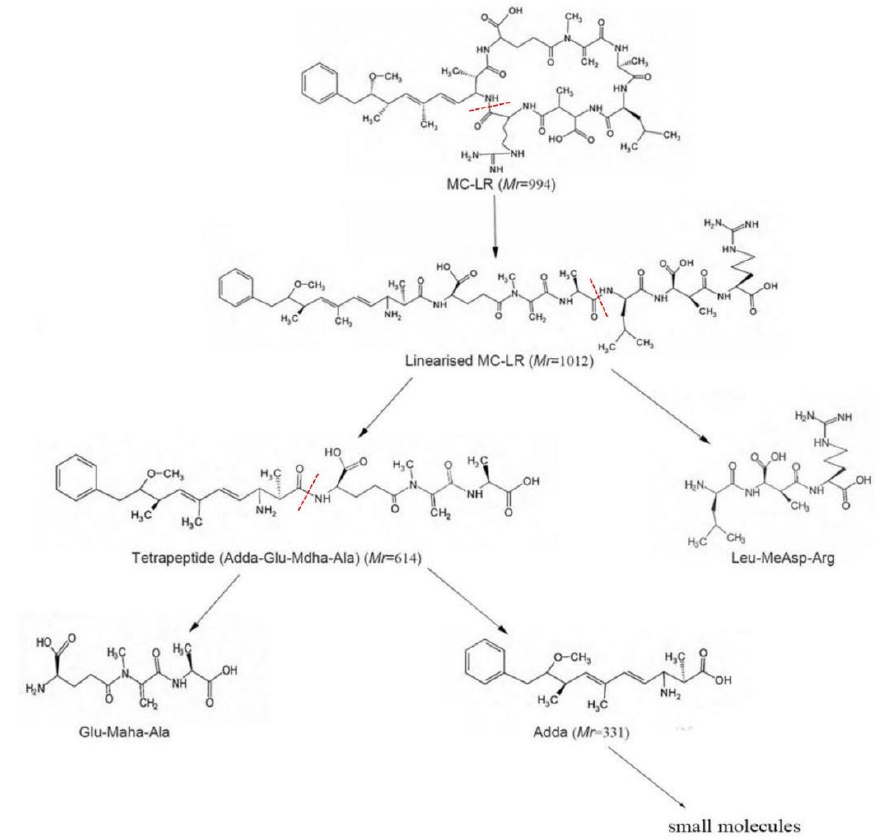
Figure 8. Possible degradation pathway of MC-LR by strain a7. The position of cleavage is marked with an arrow ( ↓ ).